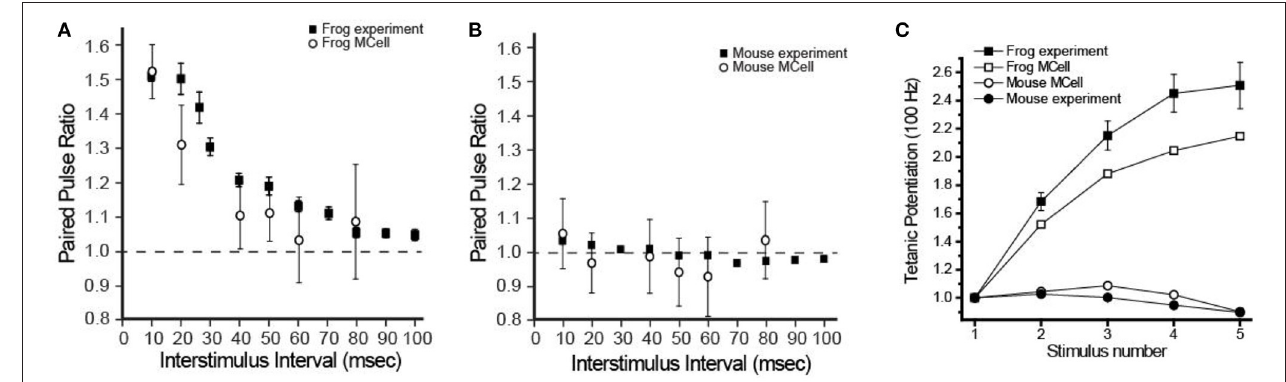
FIGURE 6 | Comparison of physiological recordings and MCell model output of short-term synaptic plasticity in frog and mouse NMJs. (A) The paired-pulse facilitation (at different inter-stimulus intervals) observed at the frog NMJ can be reproduced the frog MCell model. (B) A simple rearrangement in the organization of elements in the frog MCell model into the organization observed in the mouse AZ predicts the lack of short-term plasticity during the paired-pulse protocol at different inter-stimulus intervals. (C) A plot of tetanic potentiation at 100Hz in the frog (filled squares) and mouse (filled circles) is closely predicted by MCell simulation results of the frog AZ (open squares) and the mouse AZ (open circles) models. Adapted from Laghaei et al. (2018).